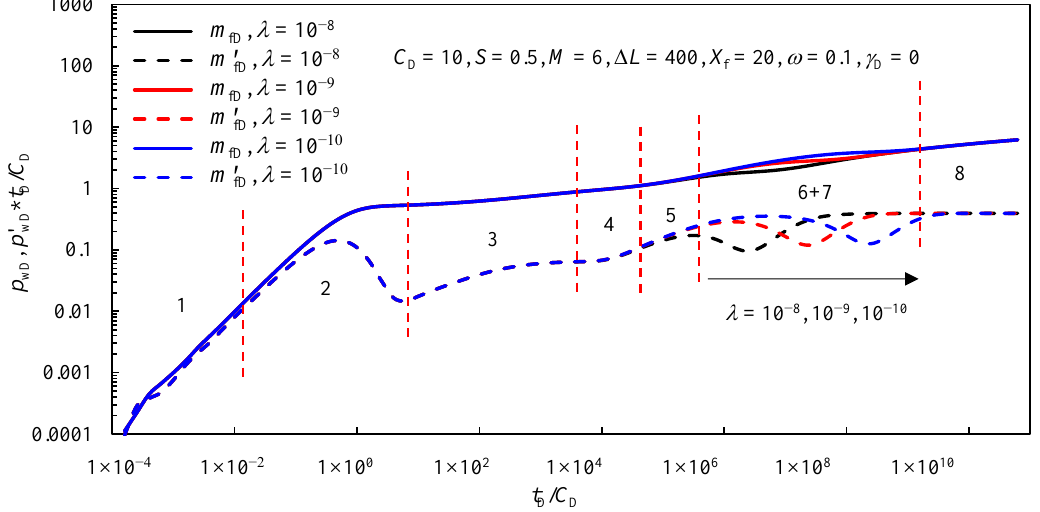
Figure 7. The effect of the interporosity flow coefficient on the dimensionless pressure and pressure derivatives of a MFHW in an inter-salt shale oil reservoir.